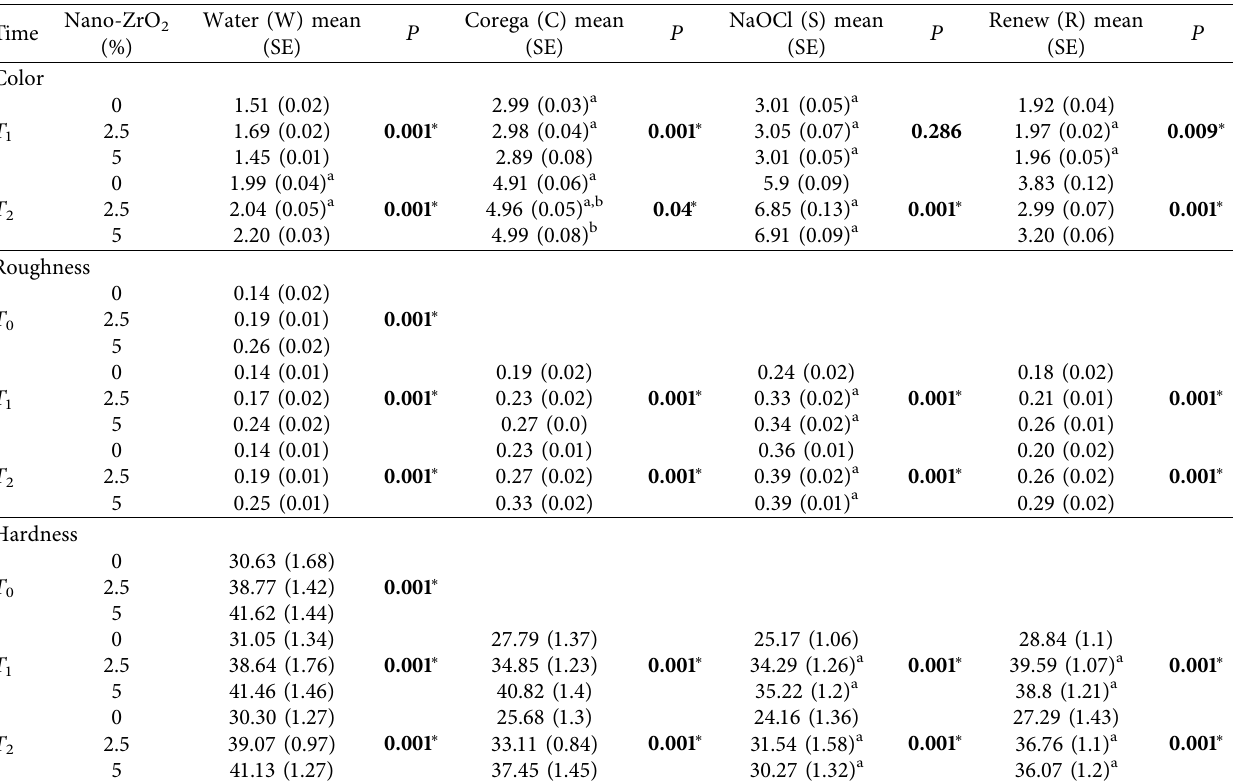
Table 4: Effect of variation in ZrO 2 concentration on acrylic specimen color ( Δ E ), surface roughness (m μ ), and hardness (VHN) after immersion in different cleansing solutions for the specific